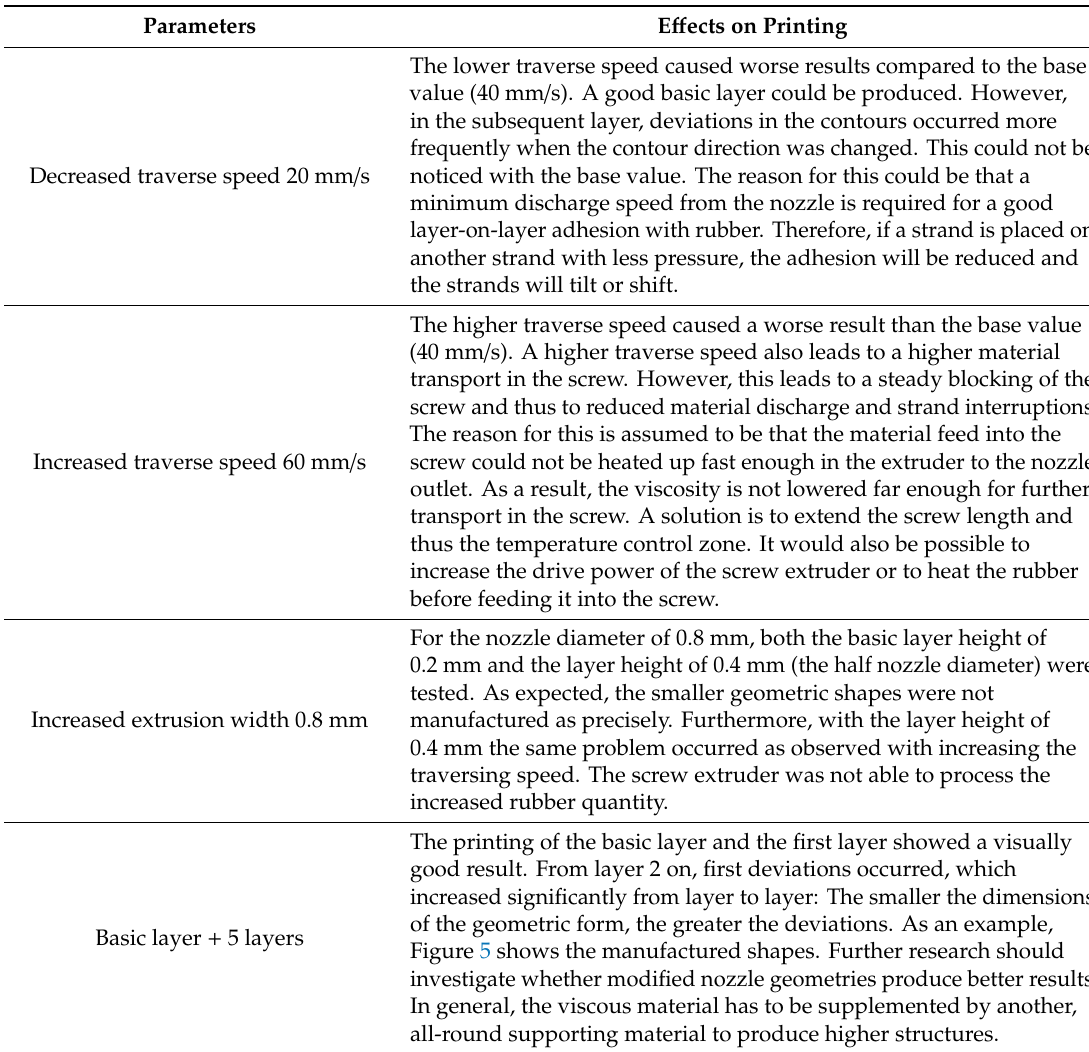
Figure 6. Examples of printing results with the nozzle diameter of 0.4 mm. The prints show a good formation of the geometric forms, but also a nozzle dripping: ( a ) Sample 1 and ( b ) Sample 2. Table 5. The parameter variation and their e ff ect on the 3D